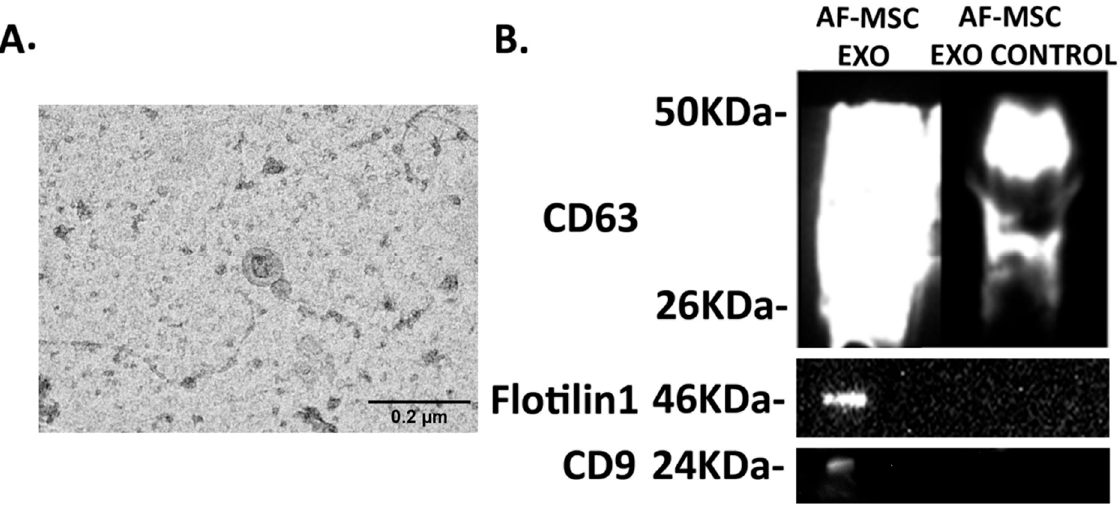
Figure 2. AF-MS-EXO characterization: ( A ) The size of exosomes was confirmed using TEM. Scale bar 0.2 μ m. Original magnification 60,000×. ( B ) The expression of CD63, Flotilin1, and CD9 was 0.2 µ m. Original magnification 60,000 × . ( B ) The expression of CD63, Flotilin1, and CD9 was detected detected by Western blotting. AF-MSC-EXO: AF-MSC-exosomes; AF-MSC-EXO control: AF-MSC- by Western blotting. AF-MSC-EXO: AF-MSC-exosomes; AF-MSC-EXO control: AF-MSC-CM that is CM that is deprived of exosomes, concentrated, and filtered. deprived of exosomes, concentrated, and